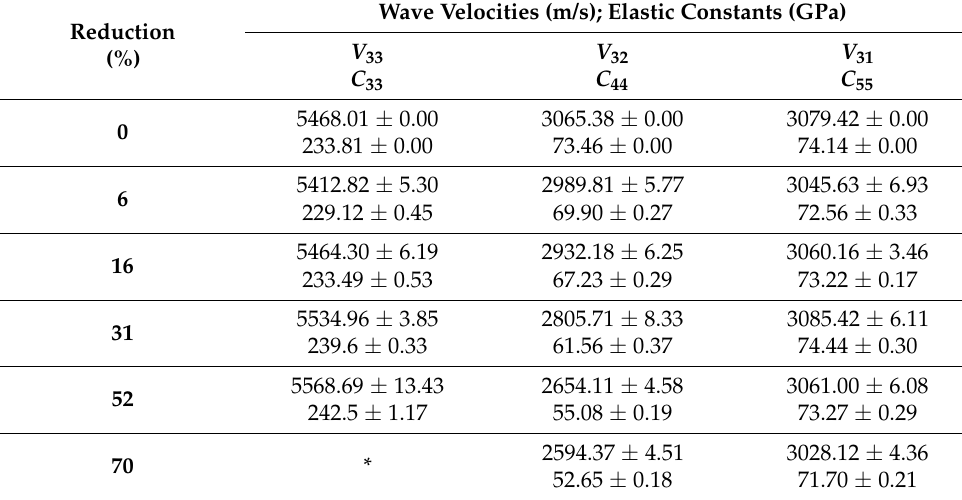
Table 3. Wave velocities and elastic constants vs. reduction by cold rolling.